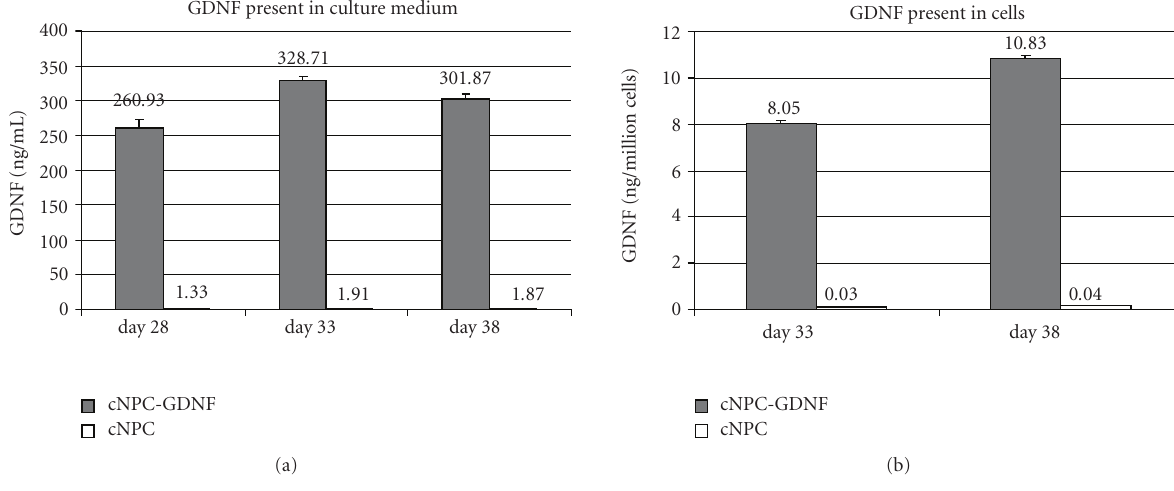
Figure 4: ELISA analysis of GDNF production by transduced cNPCs. (a) Lenti-GDNF-GFP vector transduced and nontransduced cells at passage 17 (cNPCp17) were seeded equally, under identical conditions, and allowed to grow for 15 days in UM, over which period the cells were passaged 3 times. At the time of each passage, culture media conditioned over the prior 48 hours was collected for ELISA assay. The conditioned media from transduced cNPCs was substantially enriched for GDNF compared to nontransduced cells. (b) Lenti-GDNF-GFP transduced and nontransduced cNPCp17 cells were trypsinized, lysed, and subjected to ELISA. GDNF was markedly elevated in lysates of transduced cells.